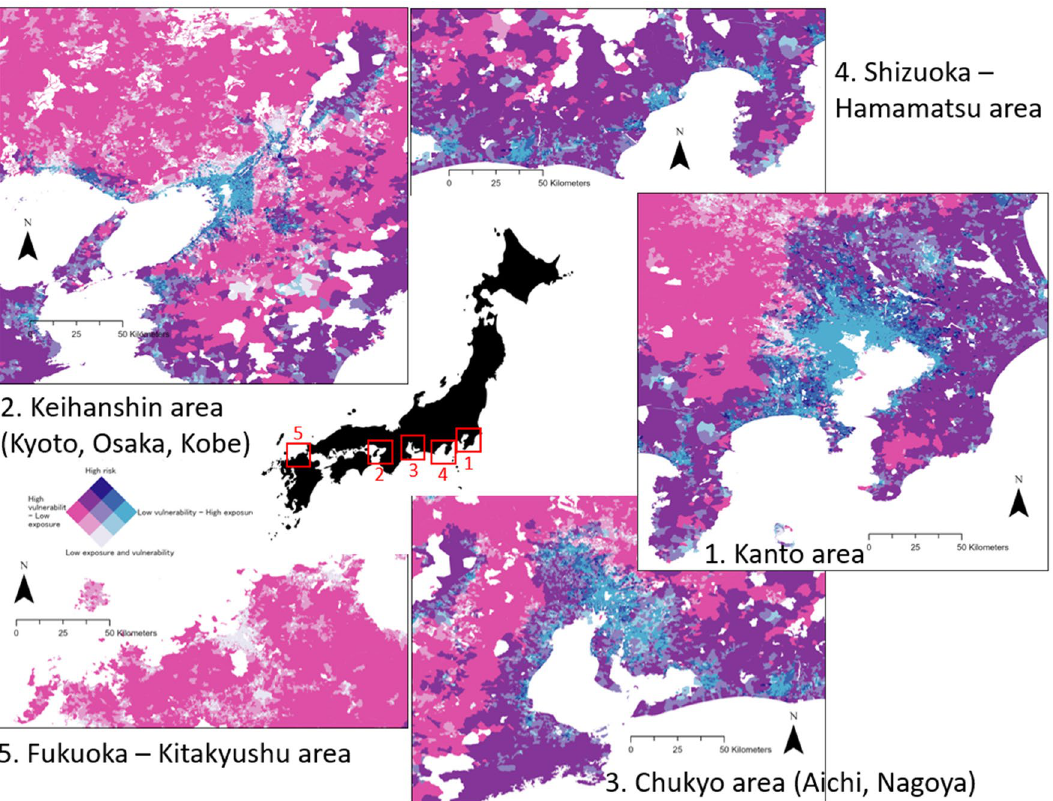
Figure 5. Earthquake risk in major urban areas in Japan (ranking by order of importance), two-dimensional legend representation of social vulnerability and population exposure to earthquake disaster. The left colour ramp (white/pink) represents 3 levels of social vulnerability while the right color ramp (white/light blue) represents 3 levels of exposure to earthquake disaster. The focus is on the high vulnerability areas with high exposure to earthquake hazard, resulting is high risk area for earthquake disaster. Map generated using ArcGIS Pro